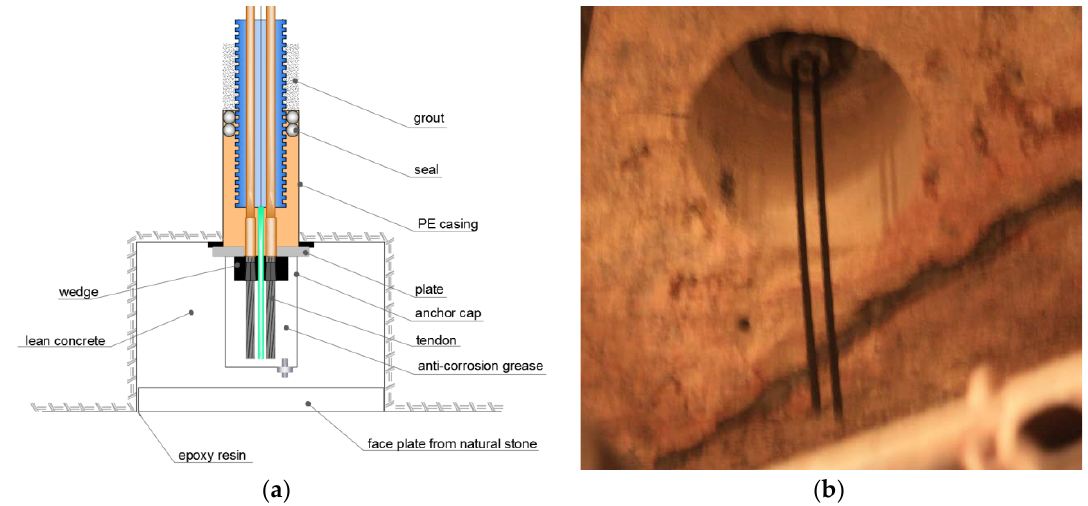
Figure 6. The pre-stressed anchor head embedded in the rock mass: ( a ) cross-section and ( b ) installation.